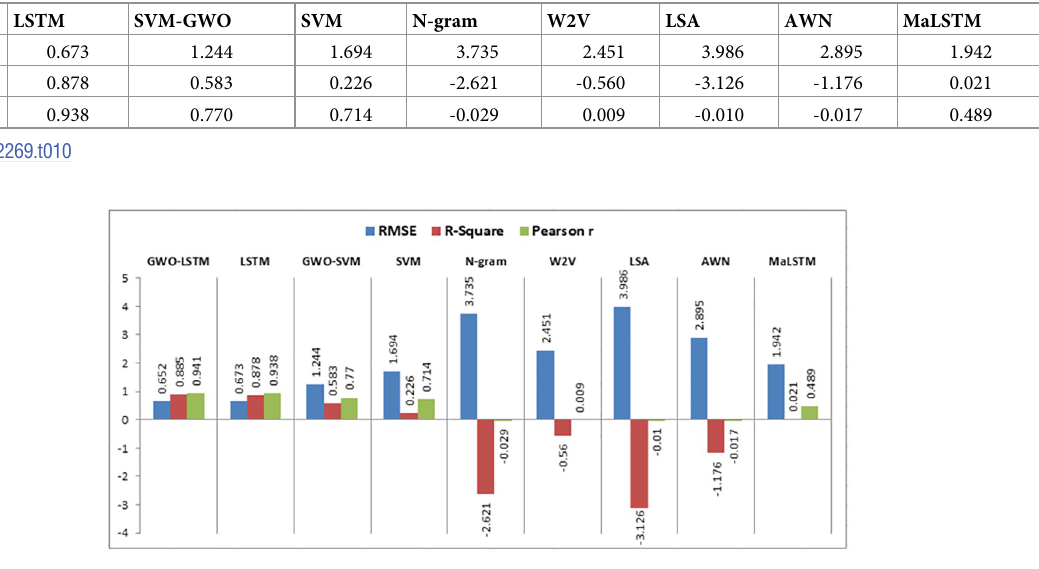
Fig 28. LSTM-GWO performance evaluation with experiment 6.